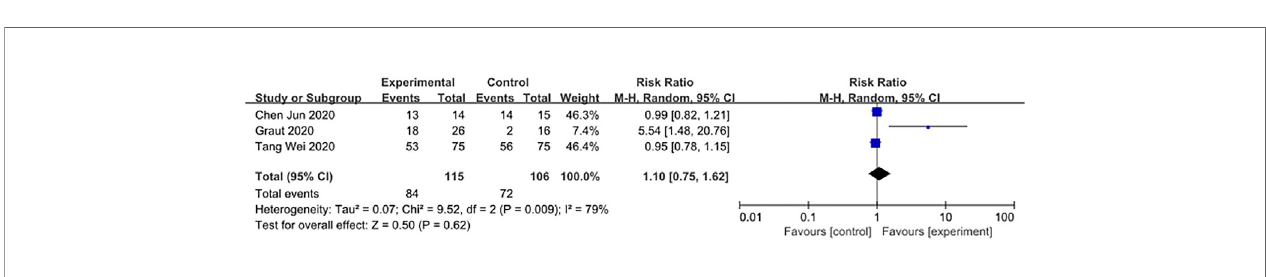
FIGURE 5 | Forest plots of Virology negative conversion rate.